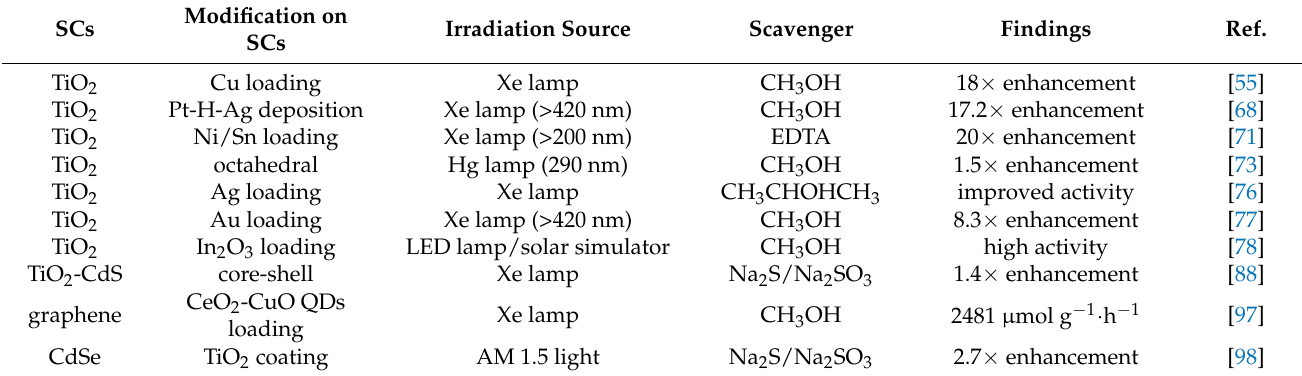
Table 1. Examples of 0D photocatalysts for photocatalytic hydrogen evolution. Scavenger Findings